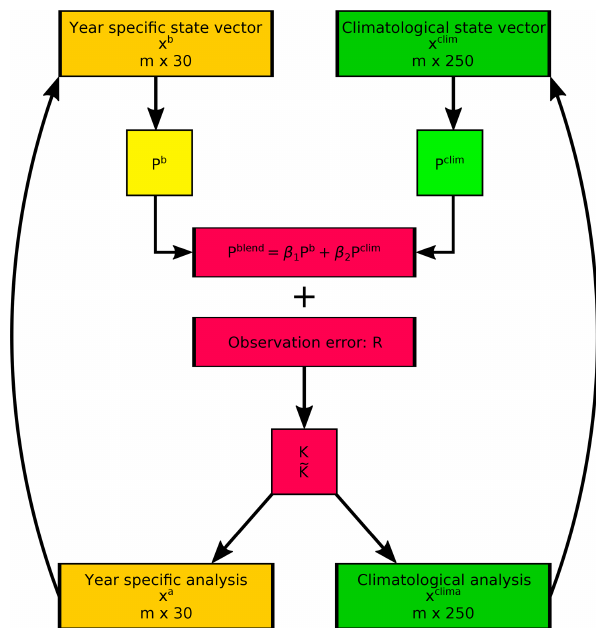
Figure 2. The main steps of the blending experiment in one assim- ilation window. The blended covariance matrix P blend is calculated as a linear combination from the year specific and climatological covariance matrices. The calculation of the Kalman gain ( K ) and reduced Kalman gain ( e K ) matrices is the same as in Eqs. (3) and (4) except the covariance matrix is replaced with P blend . The observa- tion is assimilated to both state vectors and these analysis become to the starting point for assimilating the next